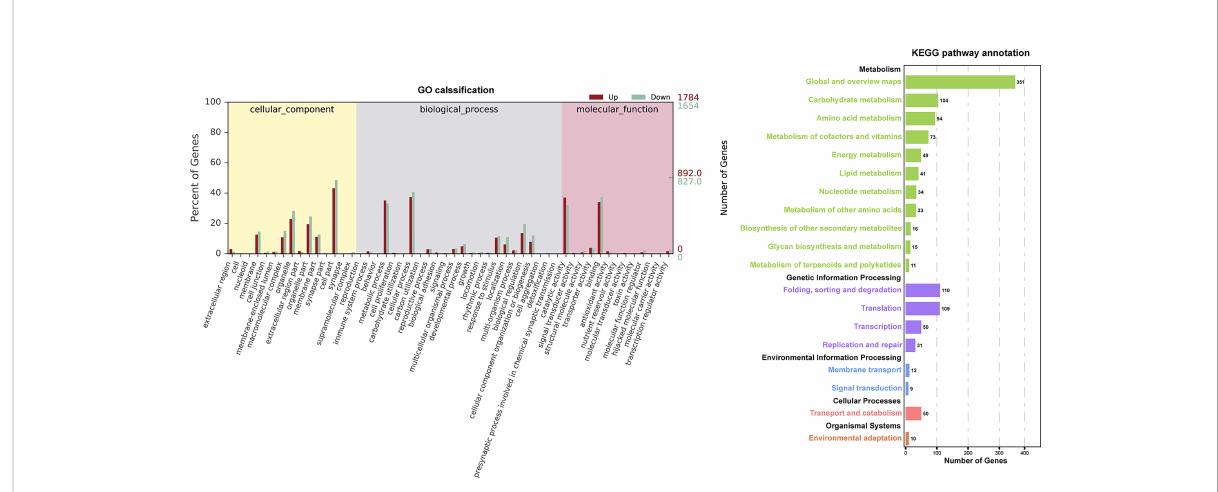
FIGURE 3 Histogram of Gene Ontology (GO) classi fi cations and Kyoto Encyclopedia of Genes and Genomes (KEGG) pathways annotation for the differentially expressed genes (DEGs) of EC and NEC. Up indicated genes up-regulated in EC. Down indicated genes up-regulated in NEC.